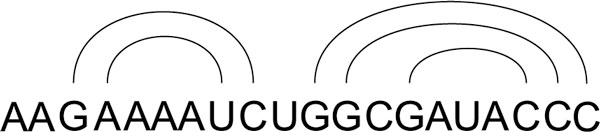
Arc representation.